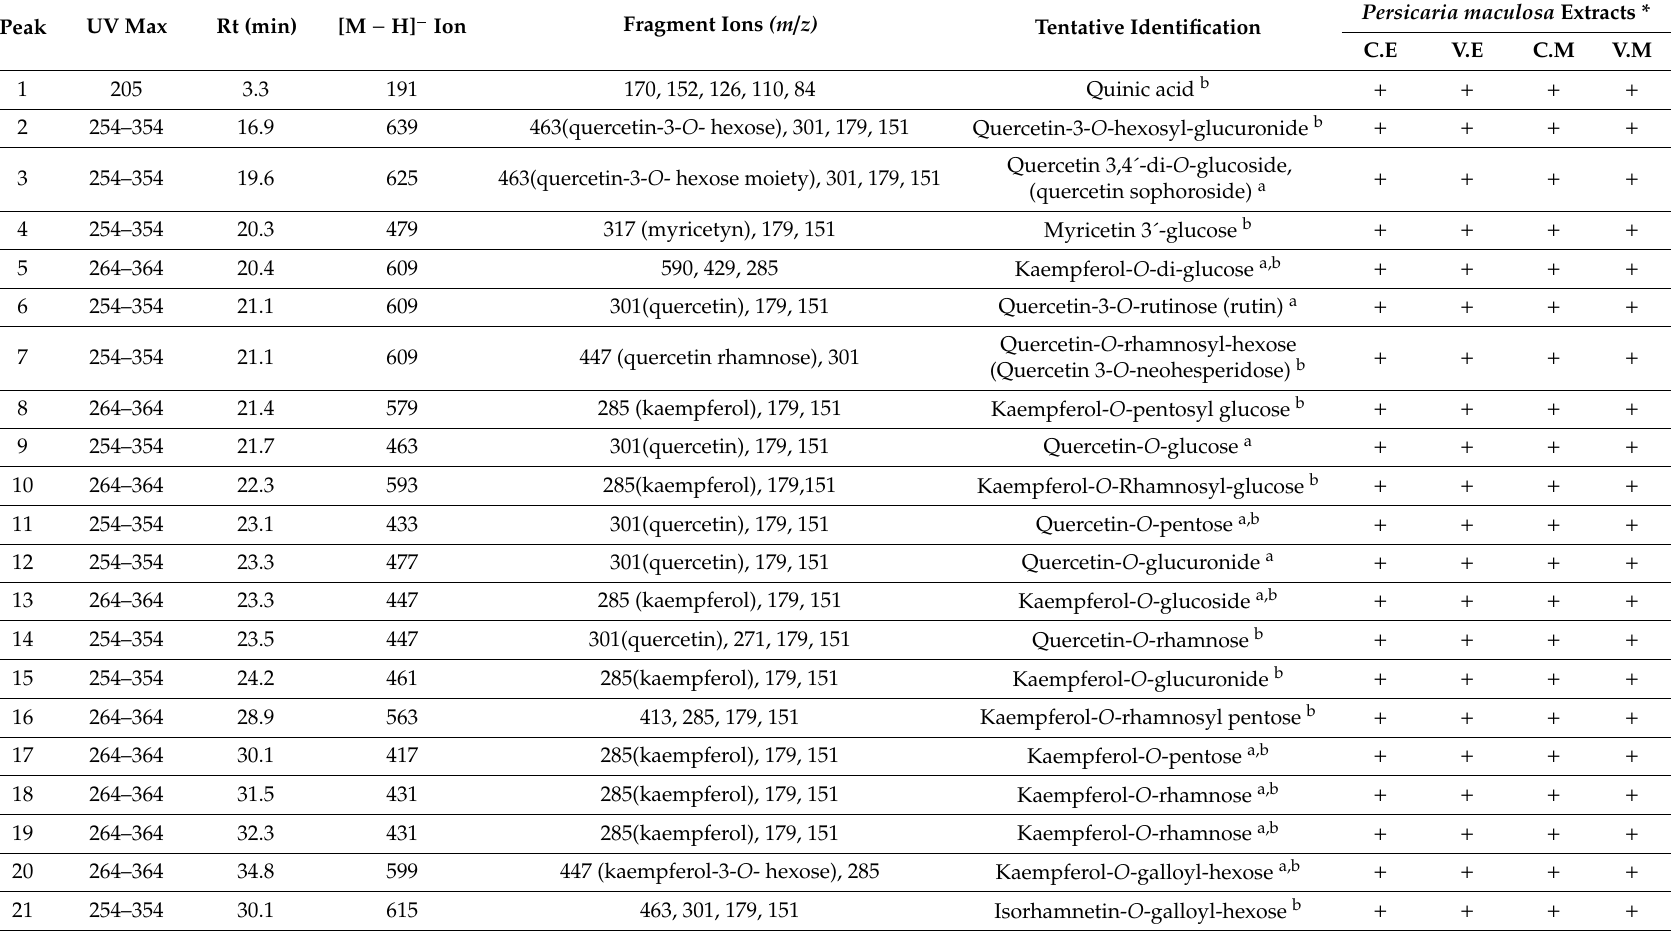
Table 3. Tentative HPLC electrospray mass spectrometry (HPLC-ESI-MS / MS) identification of compounds in Persicaria maculosa